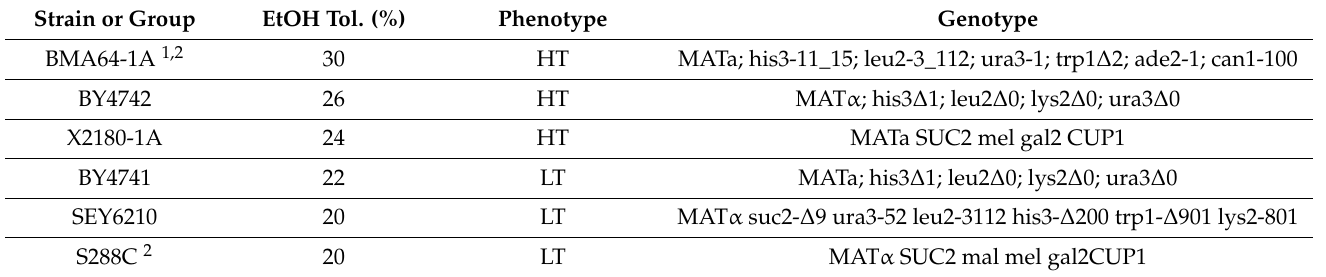
Table 1. Strain description, cell viability, and SDH assays. 1: Strain subjected to genome sequencing (Supplementary Tables S1 and S2). 2: Strains subjected to the time-course experiment. Although BMA64-1B (tolerates 26% EtOH) and CEN.PK2-1C (tolerates 20% EtOH) were also used in